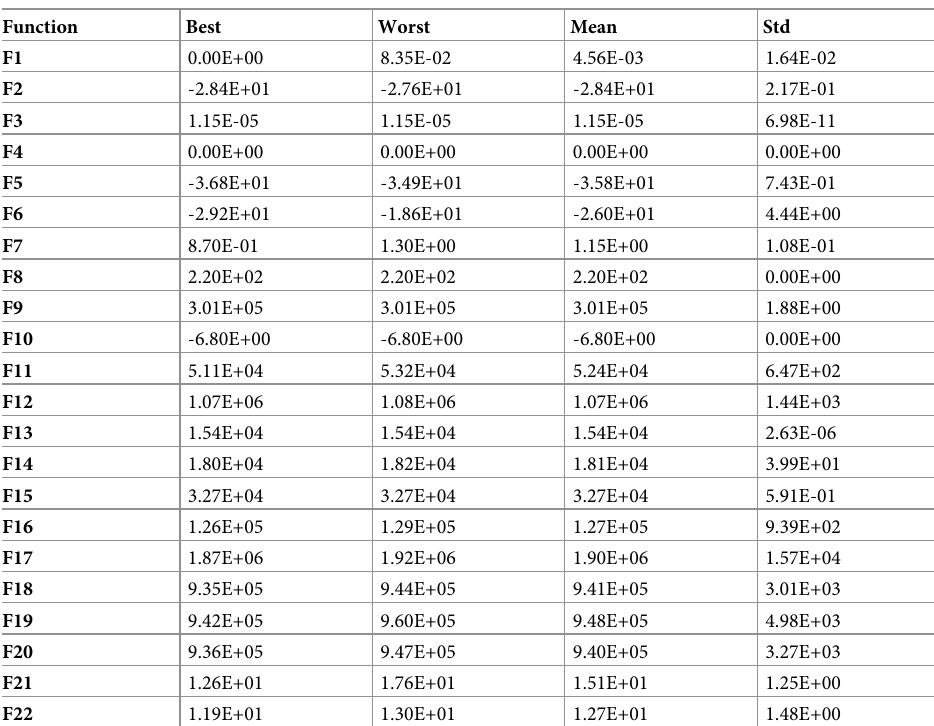
Table 16. Results of ADMO for CEC